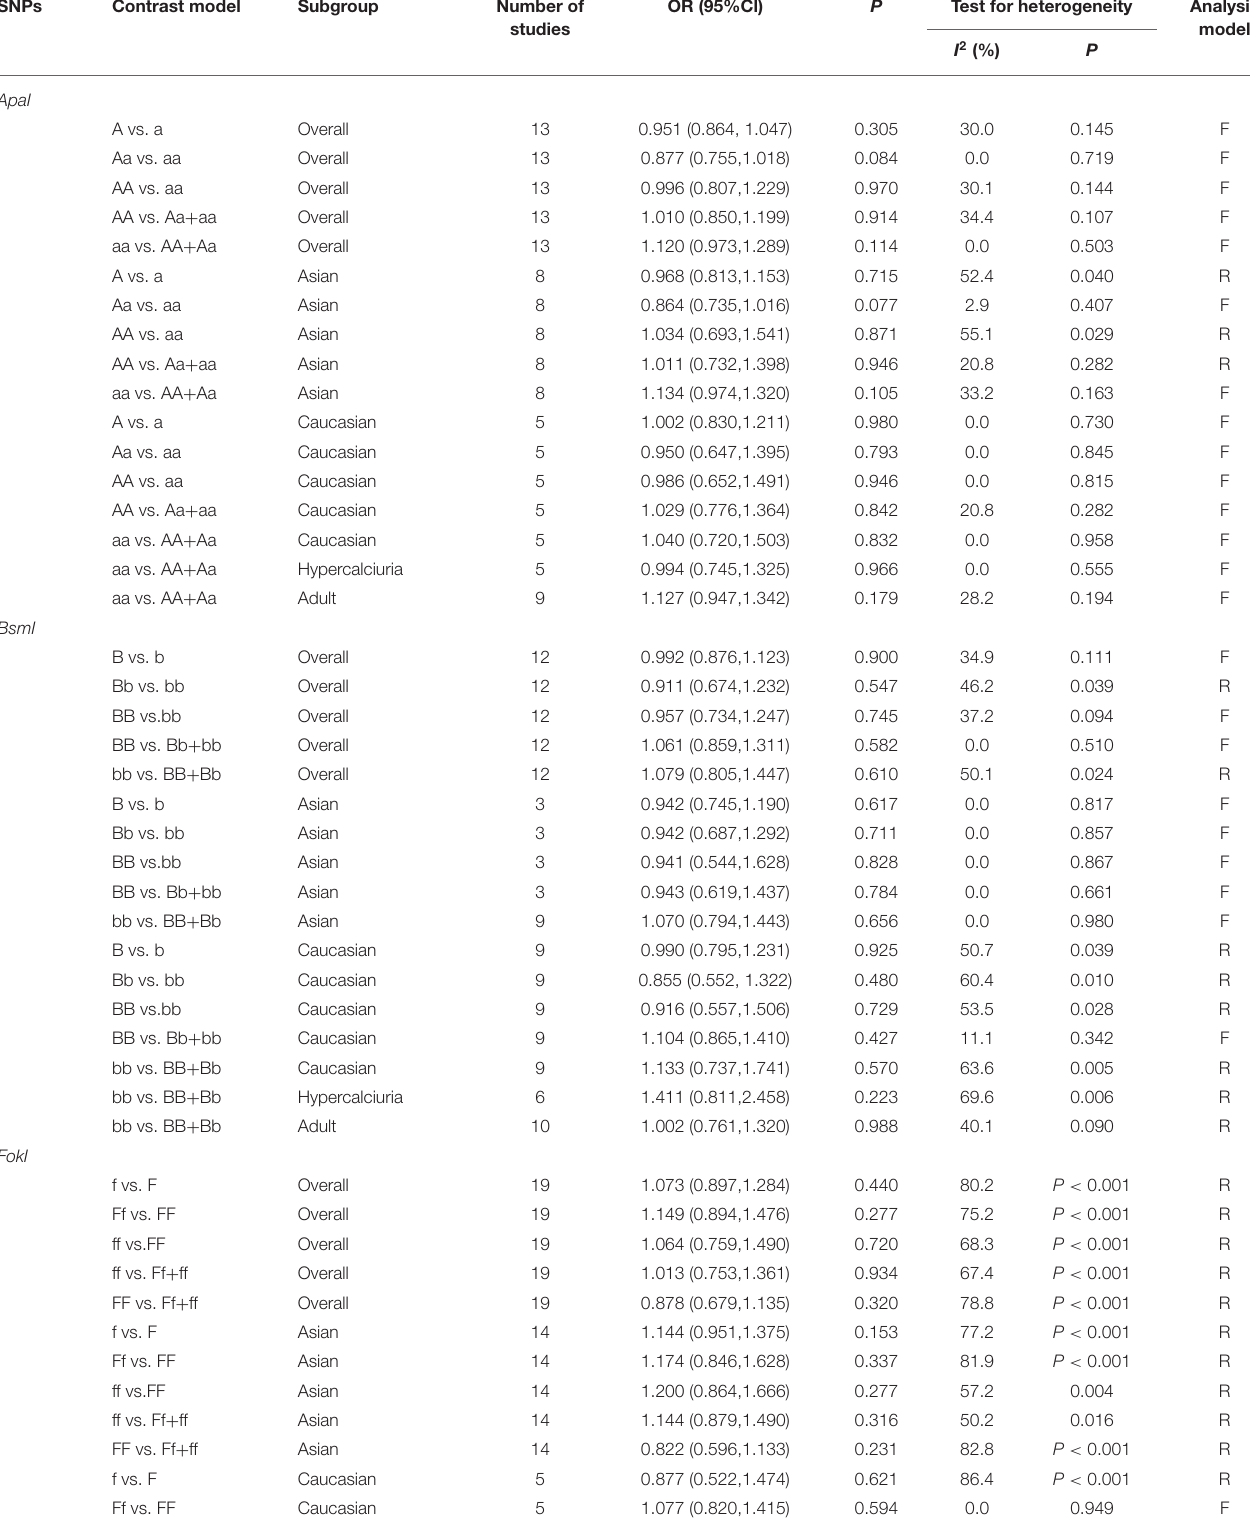
TABLE 3 | Meta-analysis